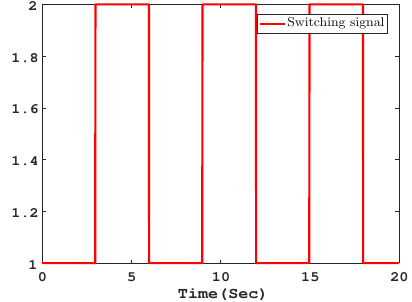
Figure 2. The trajectory of the switching signal.